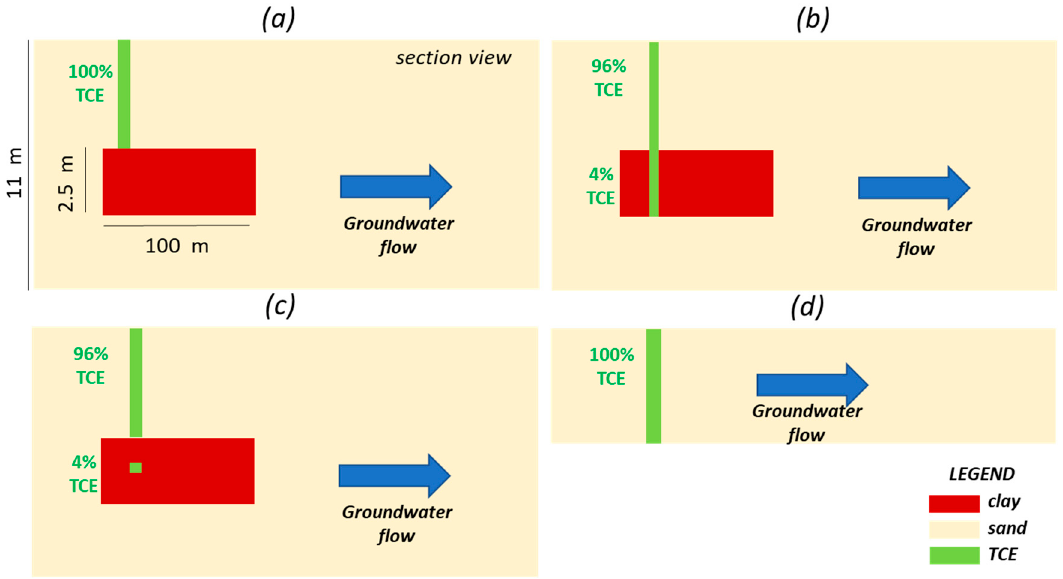
Figure 3. Graphical representation of the TCE contamination scenarios ( a – d ), simulated with ad hoc numerical models.